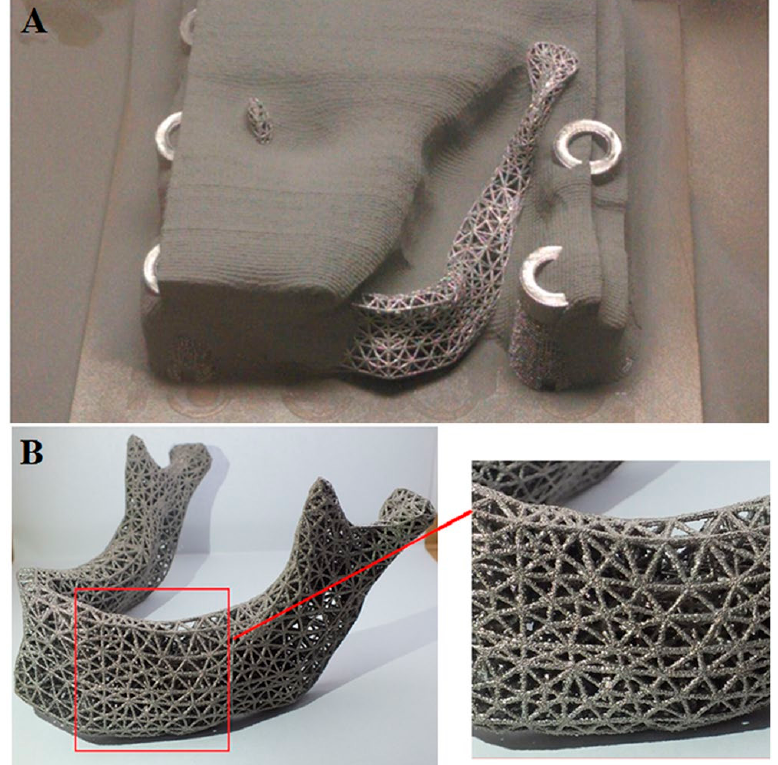
Figure 9. Preparation of Ti6Al4V scaffolds by EBM. ( A ) The parts are cleaned up to remove loose titanium powder lodged within the 3D mesh structure. ( B ) 3D mesh titanium mandibular prosthesis scaffold fabricate using EBM technology. Reprinted with permission from Ref. [155]. Copyright 2018, copyright Yan R, Luo D, Huang H.